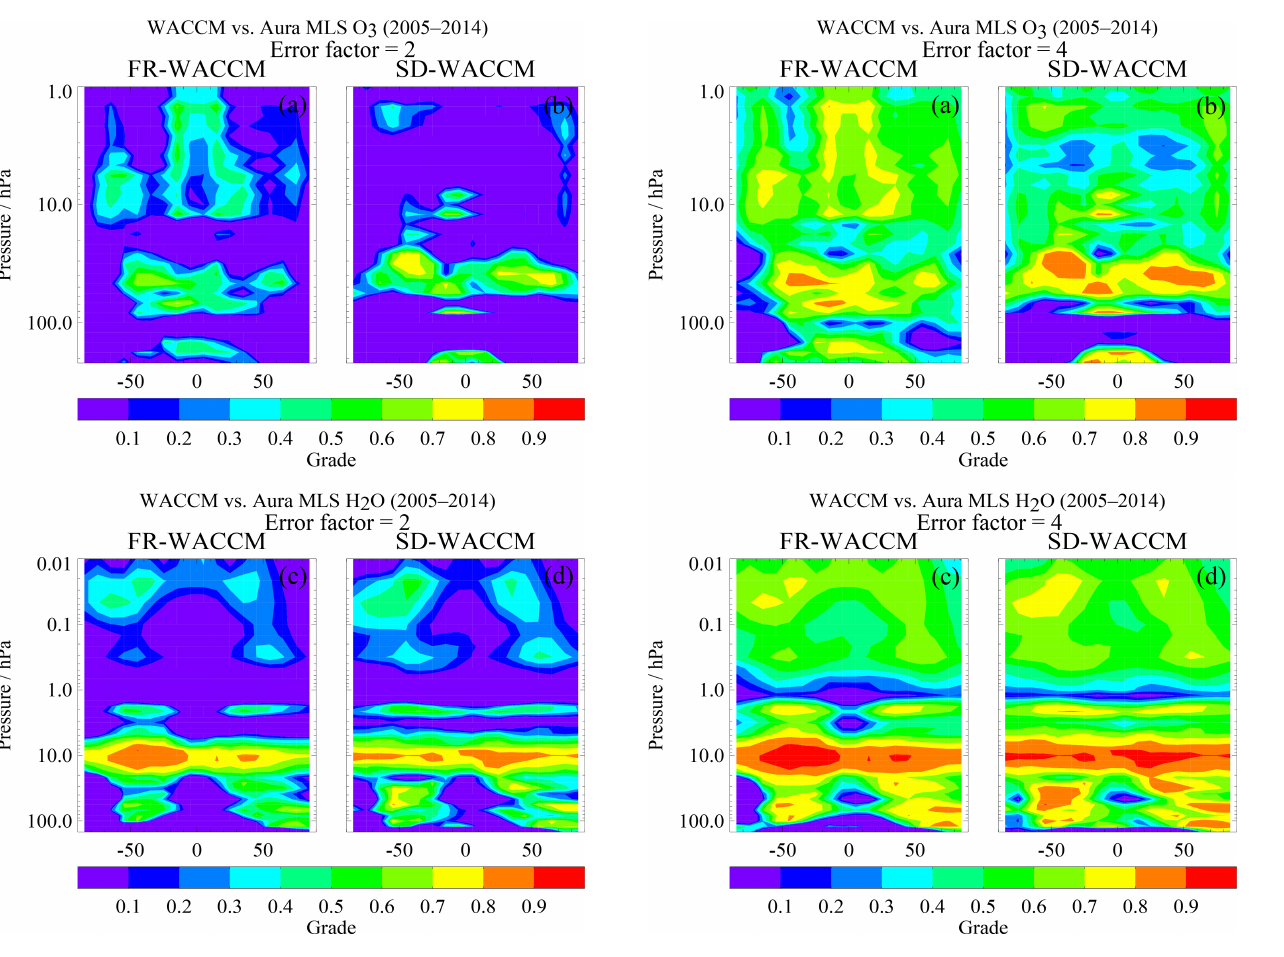
Figure A1. Examples of grades for model evaluations of O 3 (a, b) and H 2 O (c, d) , using a grading methodology that has been used in the past (see Eq. A1), applied to both FR-WACCM (a, c) and SD- WACCM (b, d) time series versus Aura MLS time series from 2005 through 2014. These grades are for an error factor of 2 (in Eq. A1).